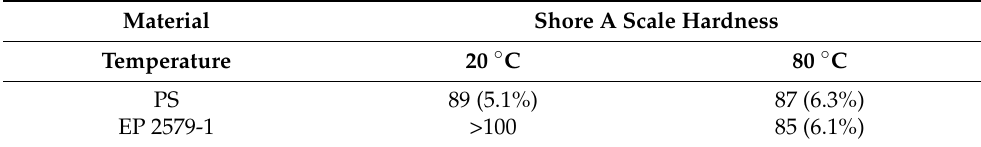
Table 4. Mean values of Shore A scale hardness for 20 ◦ C and 80 ◦ C.